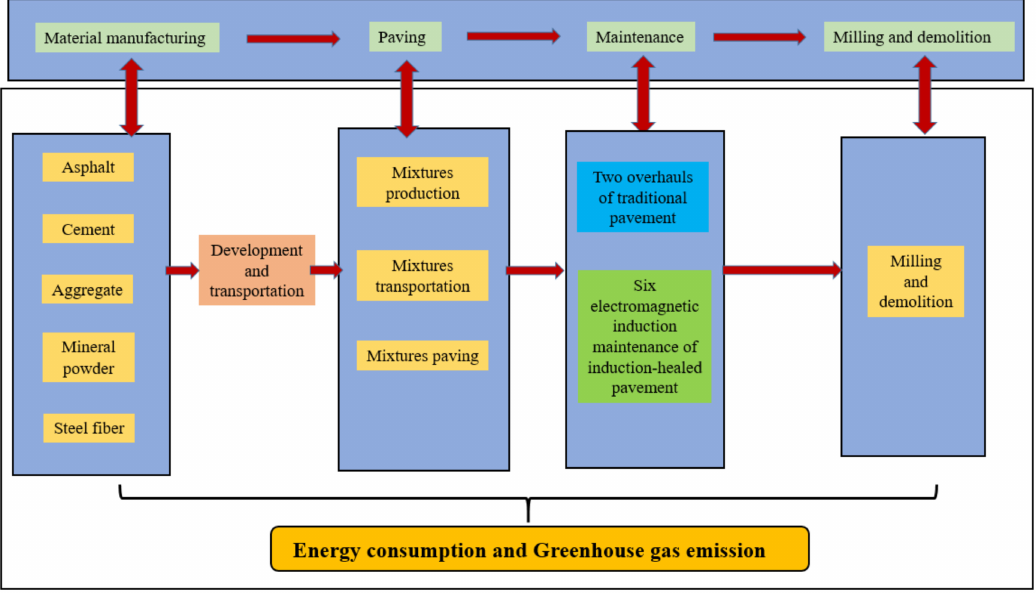
Figure 1. Life cycle assessment (LCA) boundaries.